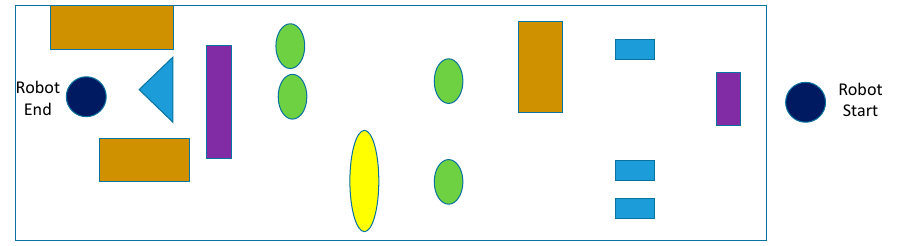
Figure 15. Static obstacles for the robot.